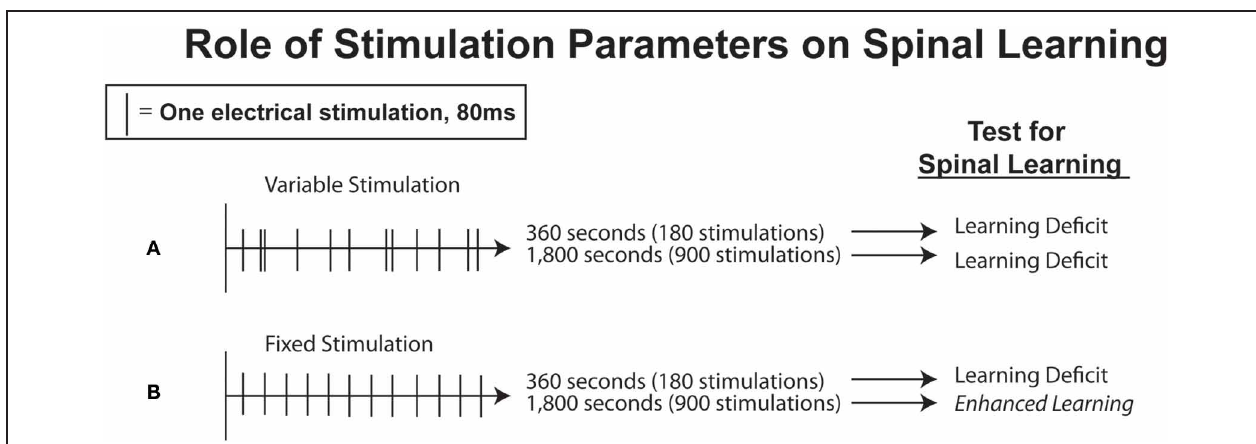
FIGURE 4 | Stimulation parameters affecting spinal learning. (A) If nociceptive electrical stimulation is delivered to the tail in a randomized, intermittent fashion, rats will fail to learn when later tested with controllable stimulation to one hindlimb. This deficit is exhibited after either short (360s) or long (1,800s) trains of intermittent, randomized stimulation.